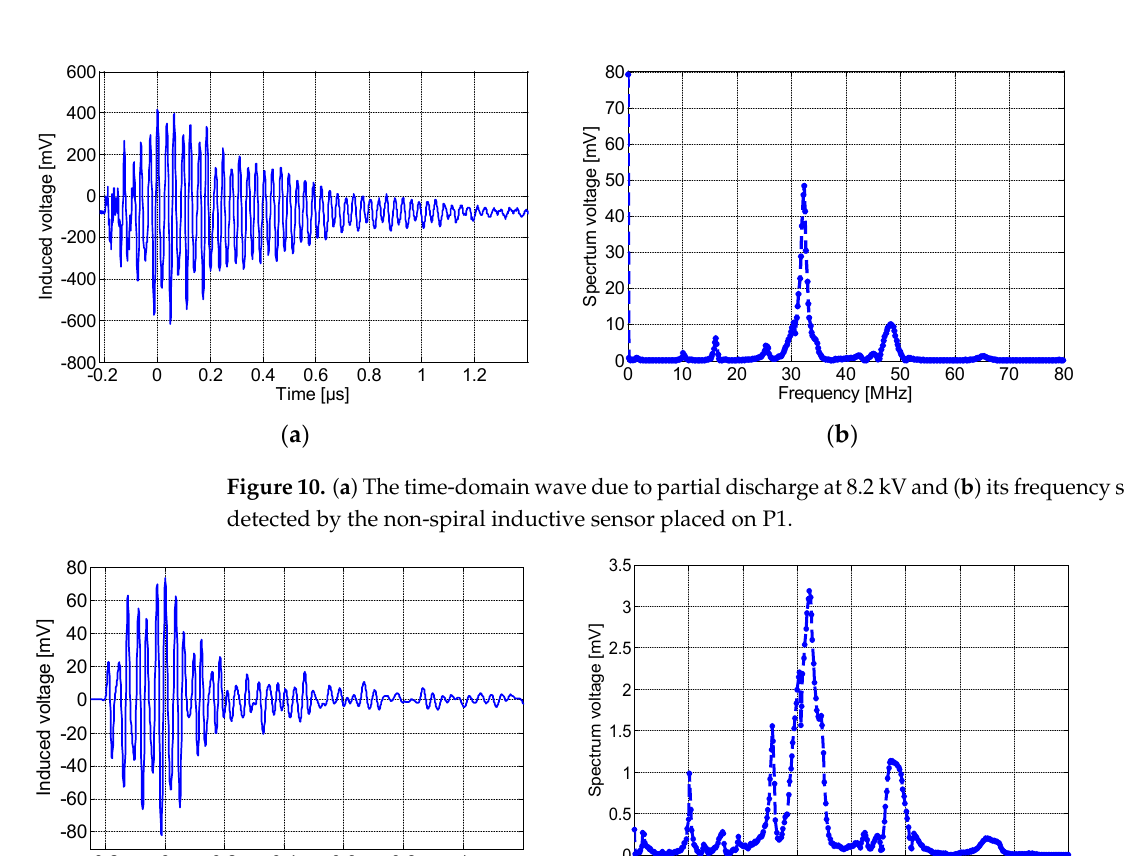
Figure 9. ( a ) The time-domain wave due to partial discharges at 8.2 kV, and ( b ) its frequency spec- trum, detected by the inductive spiral sensor placed at P1.